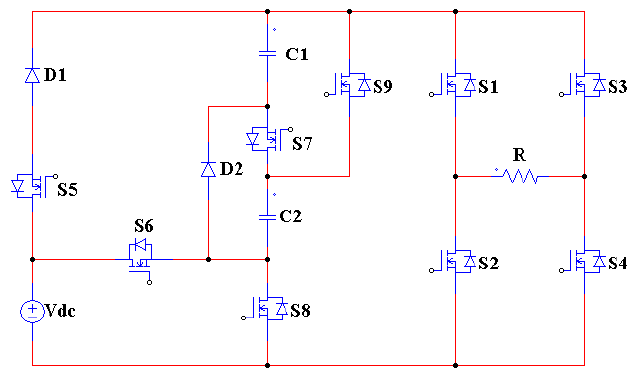
Figure 33. Circuit diagram for nine-level Inverter.